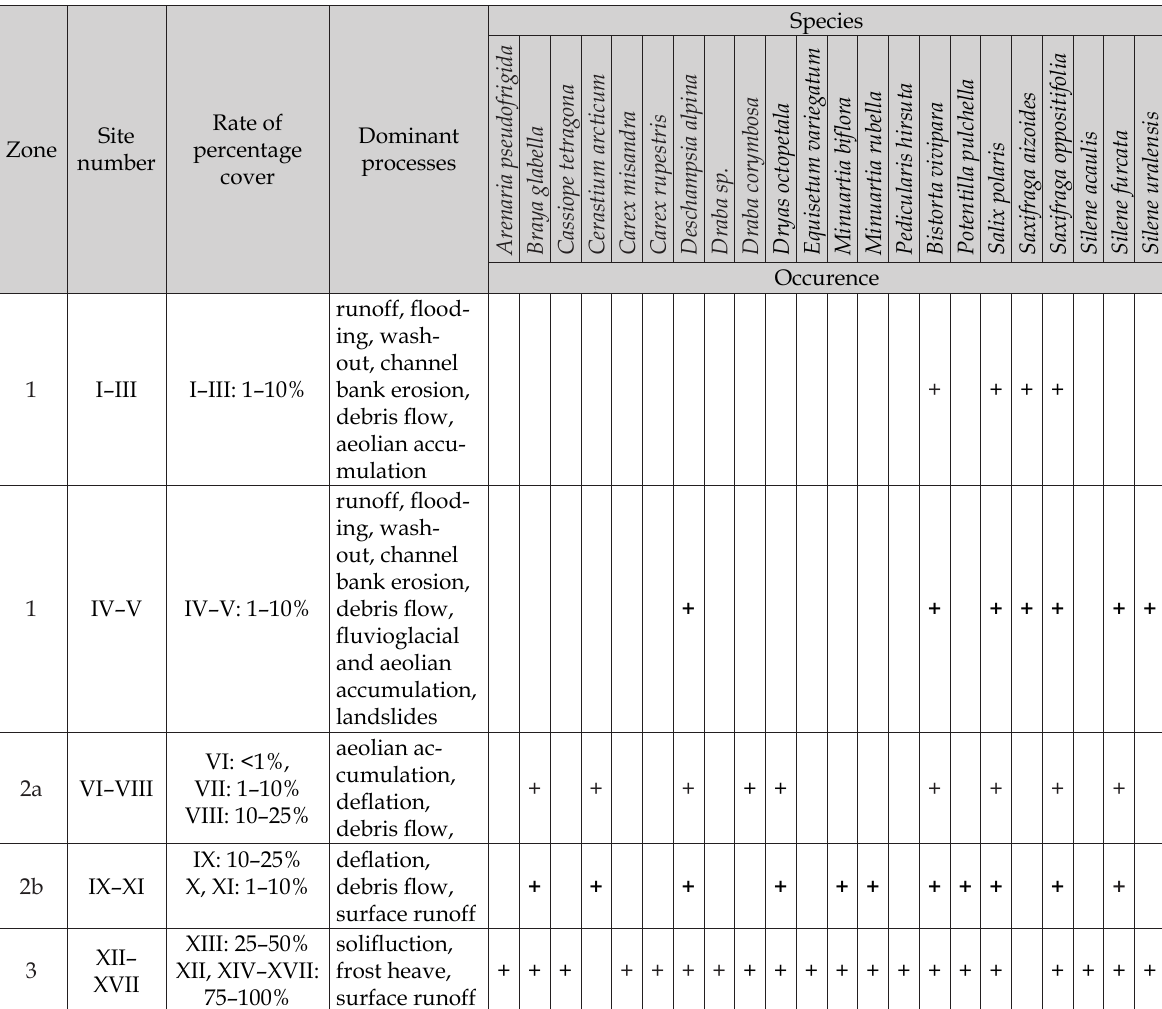
Table 2. Vascular plants documented in Ebba Valley within particular study